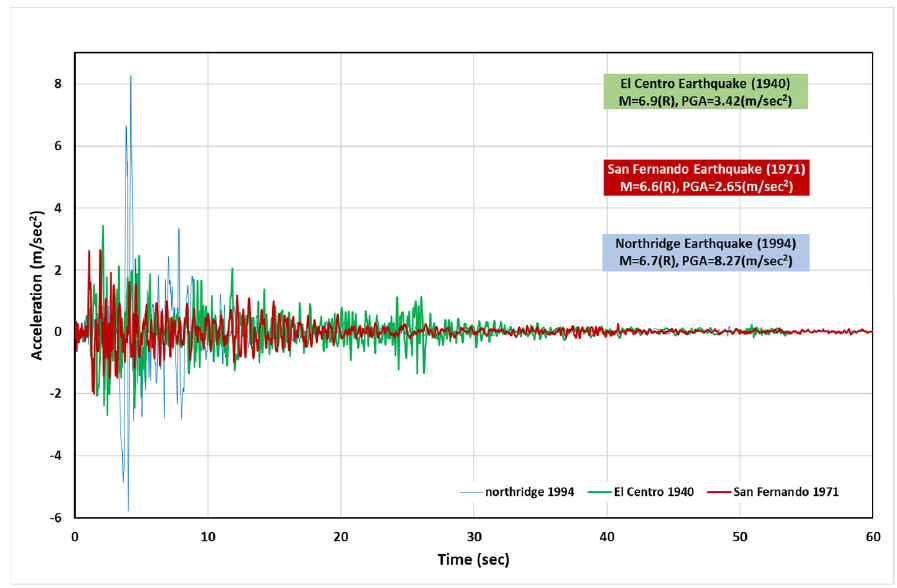
Figure 9. Acceleration time history.